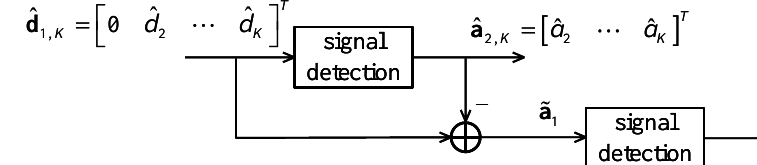
Figure 2. Successive interference cancellation algorithm.